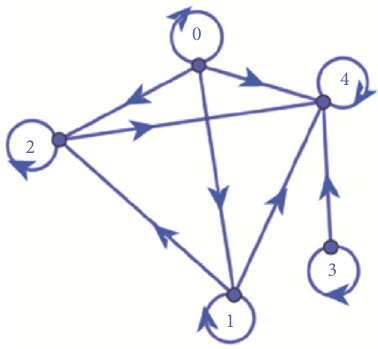
Figure 3: Graph depicting 𝐺𝑏𝑀𝑆